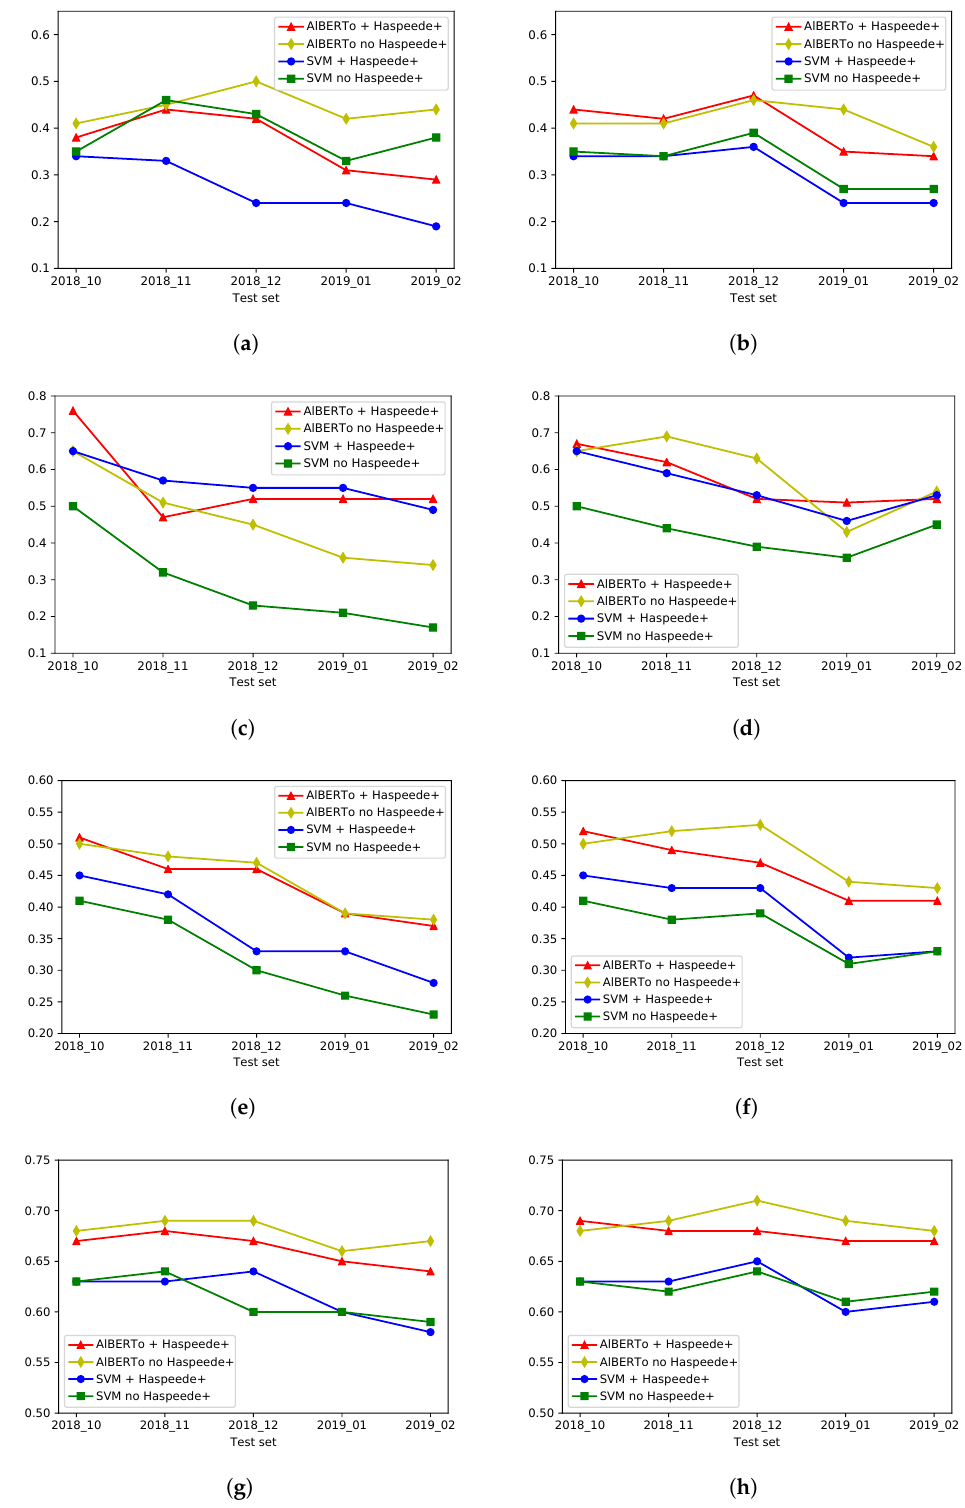
Figure 3. Evaluation of the models trained on a Sliding Windows (left columns) and Incremental dataset (right column). ( a , b ) Precision on the positive class. ( c , d ) Recall on the positive class. ( e , f ) F1-score on the positive class. ( g , h ) Macro-averaged